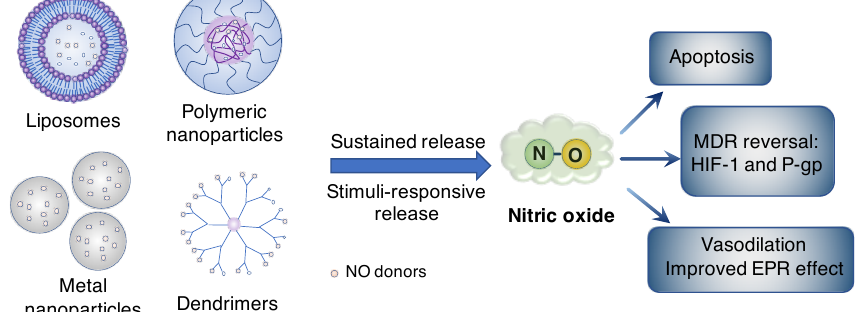
Figure 2. The structure of some important NO donors used in research and clinical settings. NTG (nitroglycerin), GLYN (glycidyl nitrate), NONOates and DETA / NO ( N -Diazeniumdiolates), SNAP (S-nitroso-N-acetylpenicillamine), SIN1 (3-morpholinosydnonimine), RRx-001 (1-Bromoacetyl-3,3- dinitroazetidine), SNP (sodium nitroprusside), GSNO (S-nitrosoglutathione). Reproduced and modified with permission [25].